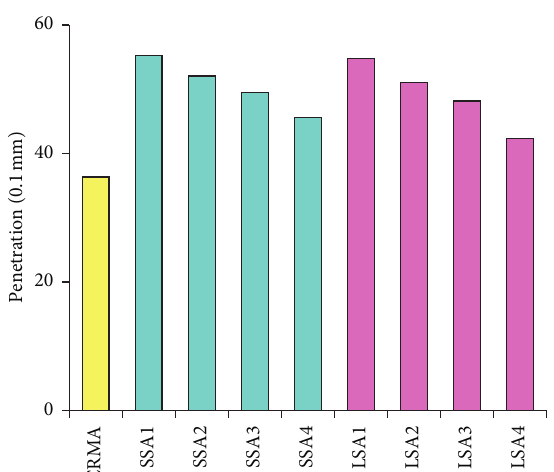
Figure 3: Penetration for each asphalt binder.